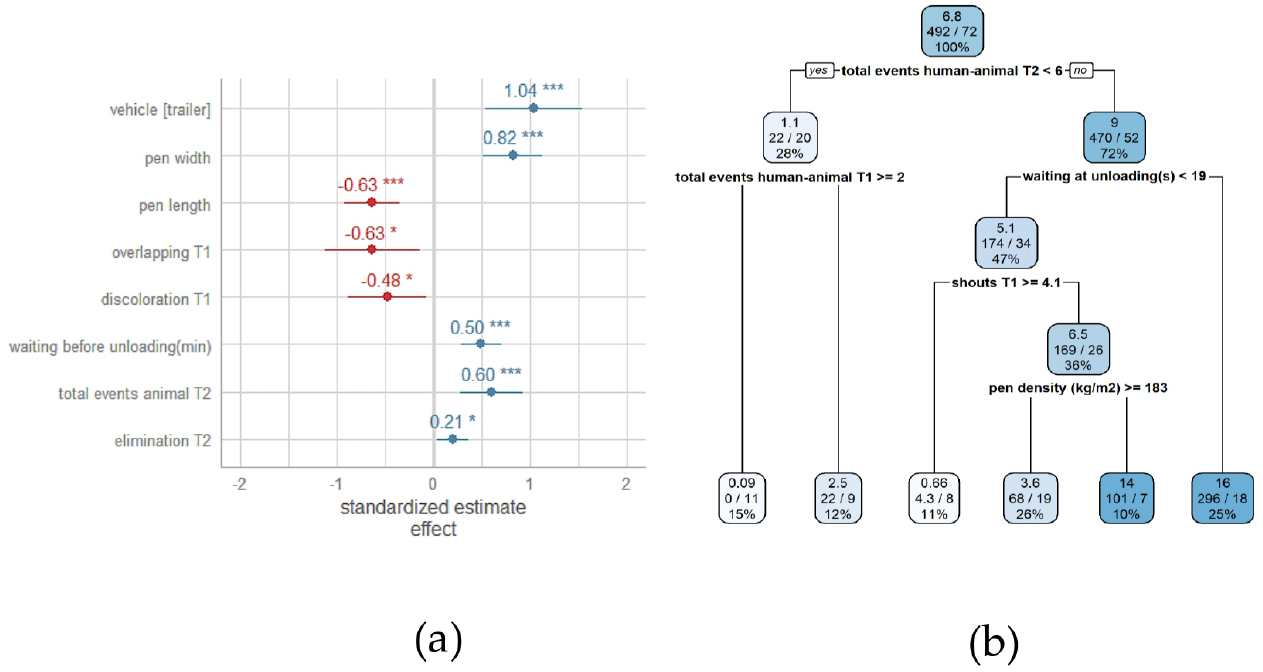
Figure 4. Association between pre-slaughter conditions and severe lesions in the front region (shoul- der) of heavy pig carcasses: ( a ) forest plot and ( b ) regression tree plot. In forest plot ( a ), * stands for p < 0.05, and *** for p <